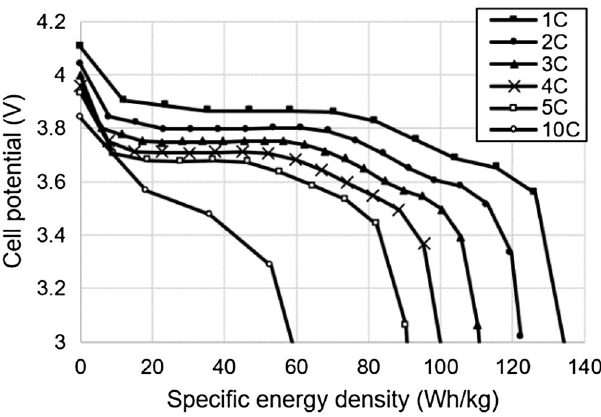
Figure 3. Discharge curves under various C rates for initial cell.